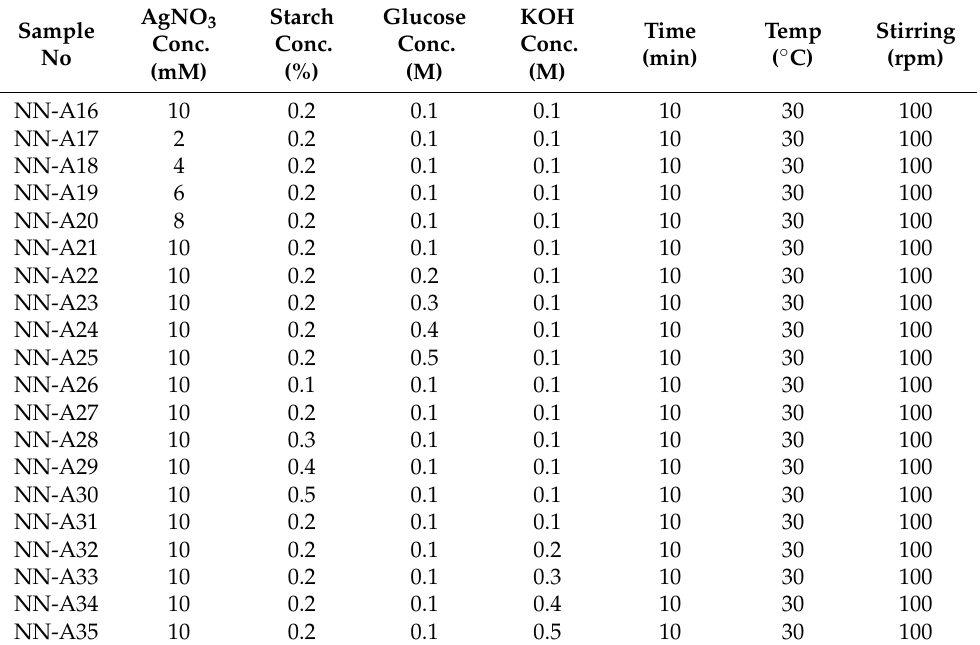
Table 2. Experimental details for different concentrations. of AgNO 3 , glucose, starch, and KOH in the synthesis of